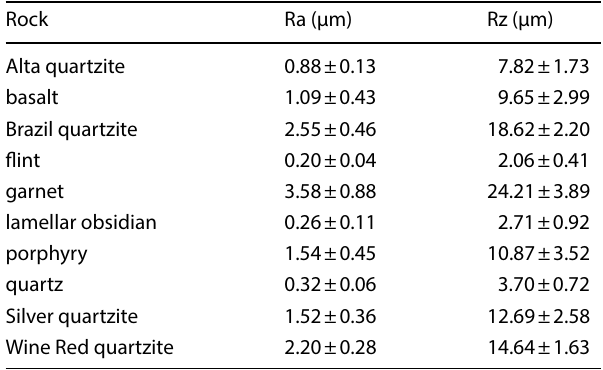
Table 2 Average surface roughness of the ten samples for the test- ing of critical bending strength Rock